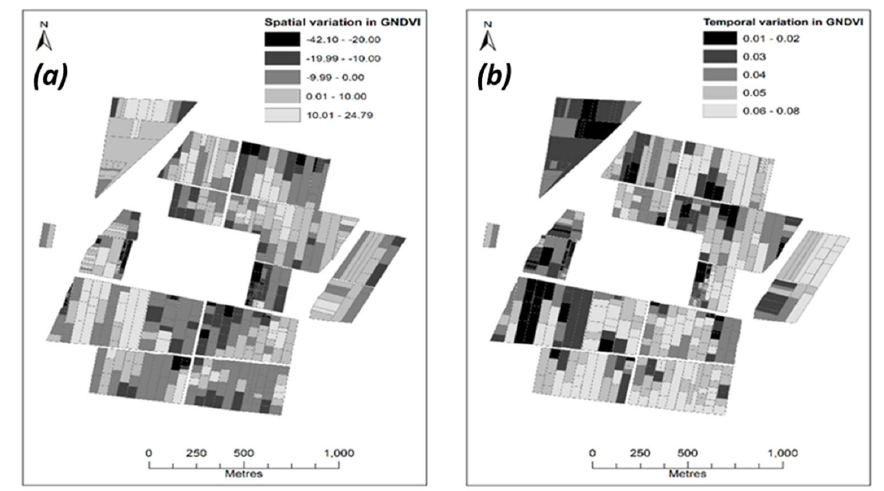
Figure 7. Ten-year time-series of GNDVI decomposed into ( a ) spatial variance and ( b ) temporal variance. Using soil brightness to define the zones resulted in the three and four zones shown in Figure 8a,b. Using the GNDVI variability metrics to define the zones resulted in the three and four zones shown in Figure 8c,d. Using a combination of soil brightness and GNDVI variability metrics to define the zones resulted in the three and four zones shown in Figure